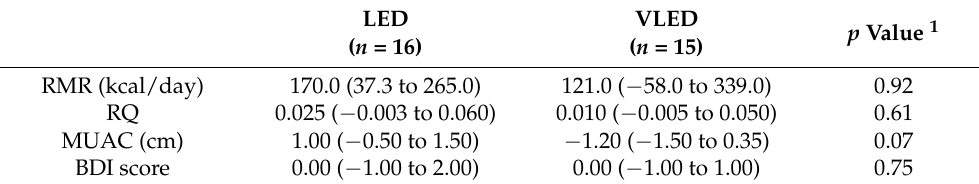
Table 5. Change ( ∆ ) in the selected outcomes from the beginning to the end of the intervention in each dietary intervention arm (median and